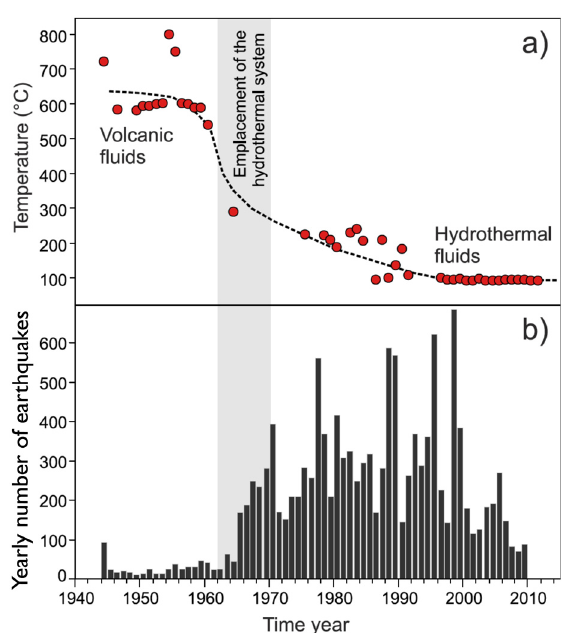
Figure 5. (a) Time behavior of the fumaroles temperature since 1944. The data before 2000 are taken from Chiodini et al. [2001], and reference therein, while the other are from Caliro et al. [2011]; (b) Number of earthquakes per year since 1944.